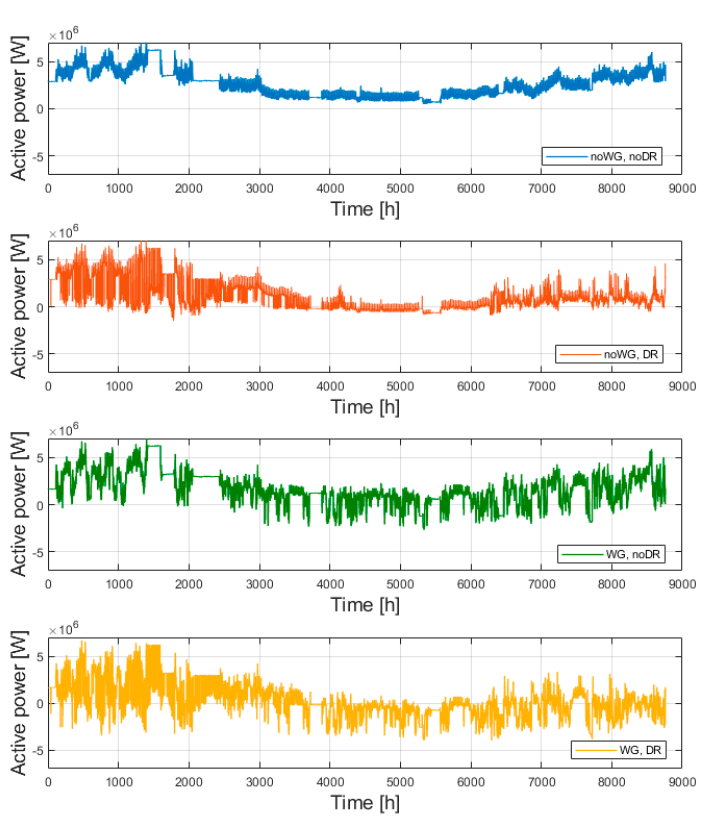
Figure 15. Demand response in the Sundom Smart Grid—active power flow in the HV/MV connection point in different case studies.